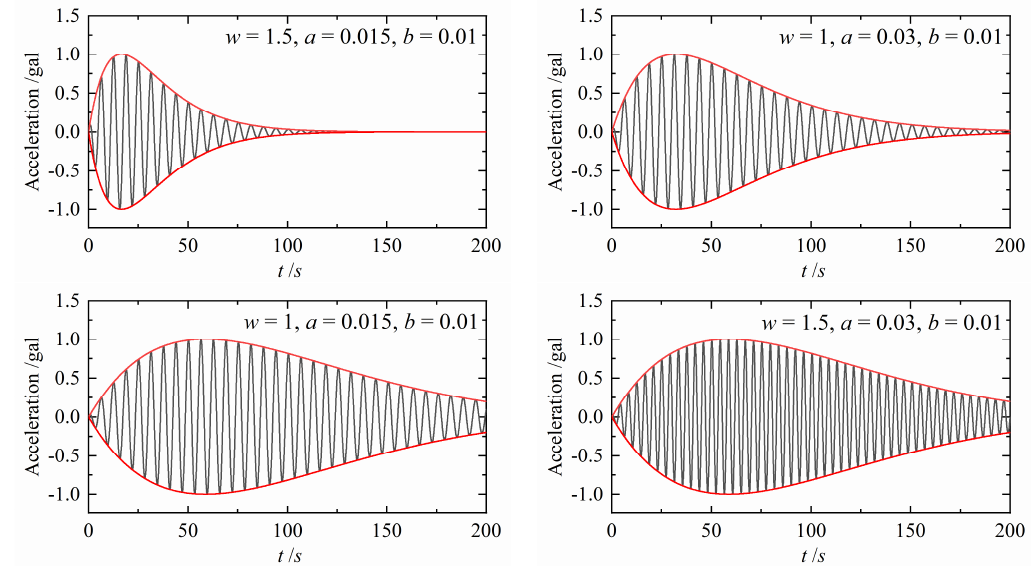
Figure 1. Intensity nonstationary model based on the damped sine function.